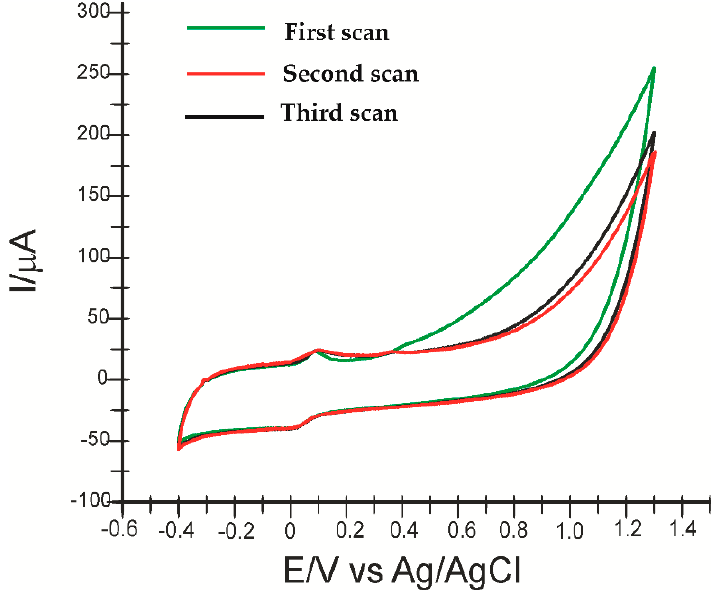
Figure 6. Cyclic voltammogram of SPE-SWCNT-Ty immersed in 10 − 4 M HT acid solution (electrolyte PBS 10 − 1 M, pH = 7.0, scan rate 0.1 V·s − 1 ): first scan (green line), second scan (red line) and third scan (black line).